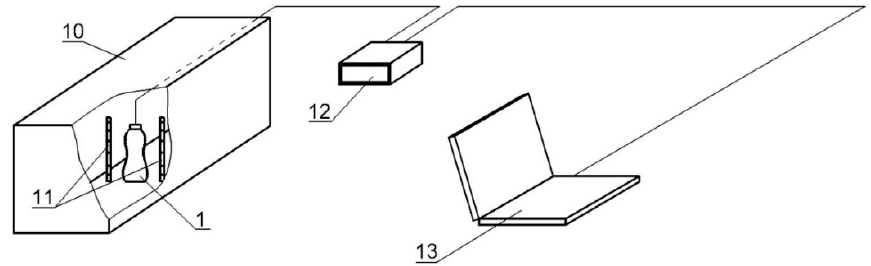
Figure 5. Schematic view of the measuring stand: 1—shrink wrapped film tested, 10—shrink tunnel, 11—nozzle layout fed from a steam generator, 12—measuring amplifier, 13—portable computer.